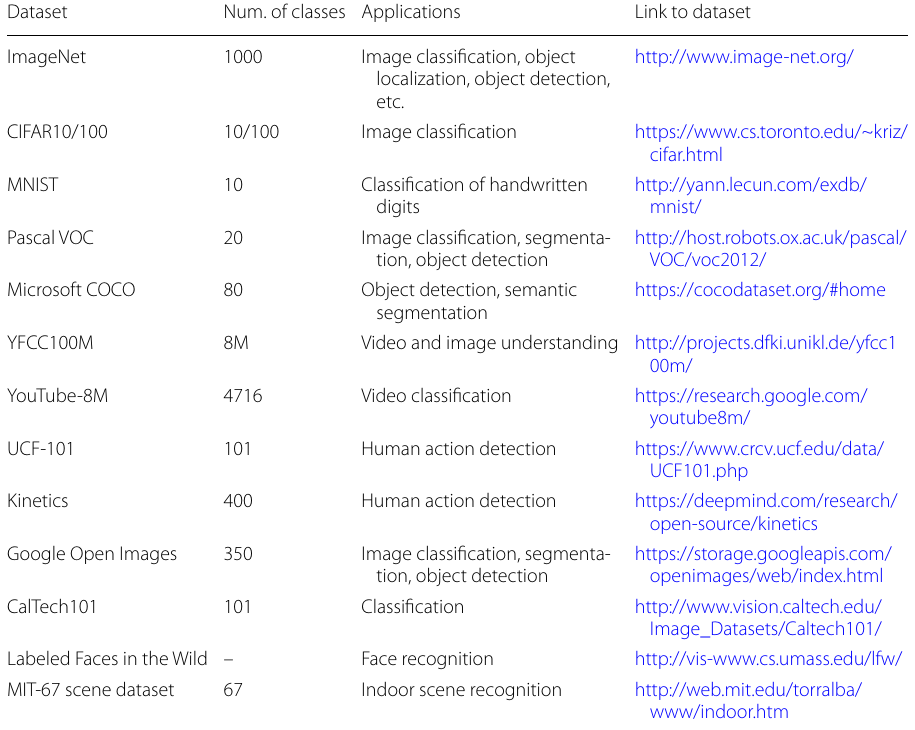
Table 5 Benchmark datasets